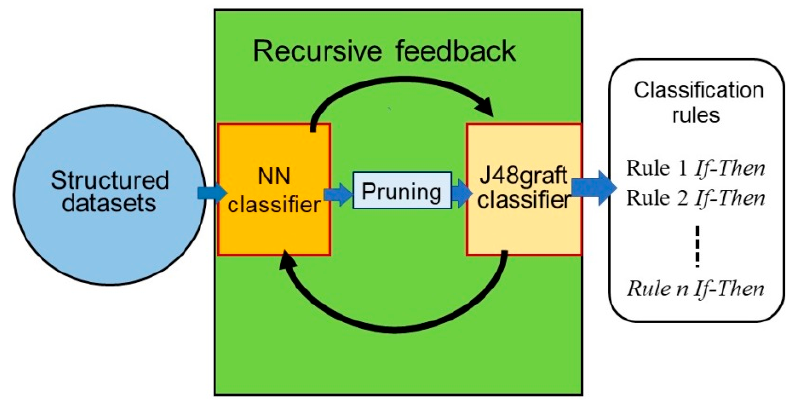
Figure 3. Schematic overview of Re-RX with J48graft.